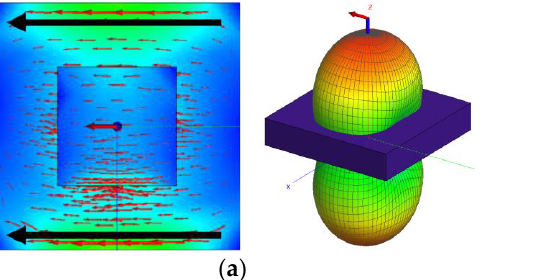
Figure 9. Scattering characteristic currents distribution and far−field patterns comparison for at 5.0 GHz. ( a ) Mode 2 of the reference antenna; ( b ) mode 2 of antenna A.